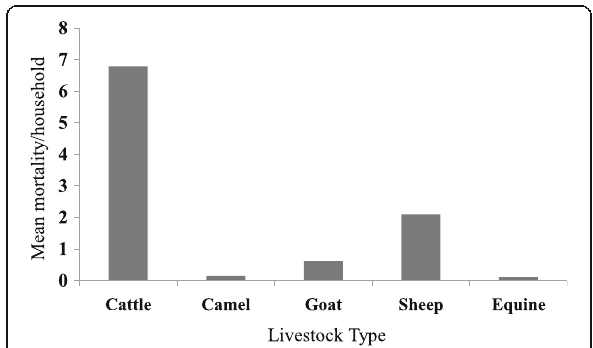
Fig. 3 Perceptions of pastoralists indicating mean values of livestock mortality per household during the 2011 drought event in the study areas in Borana, southern Ethiopia